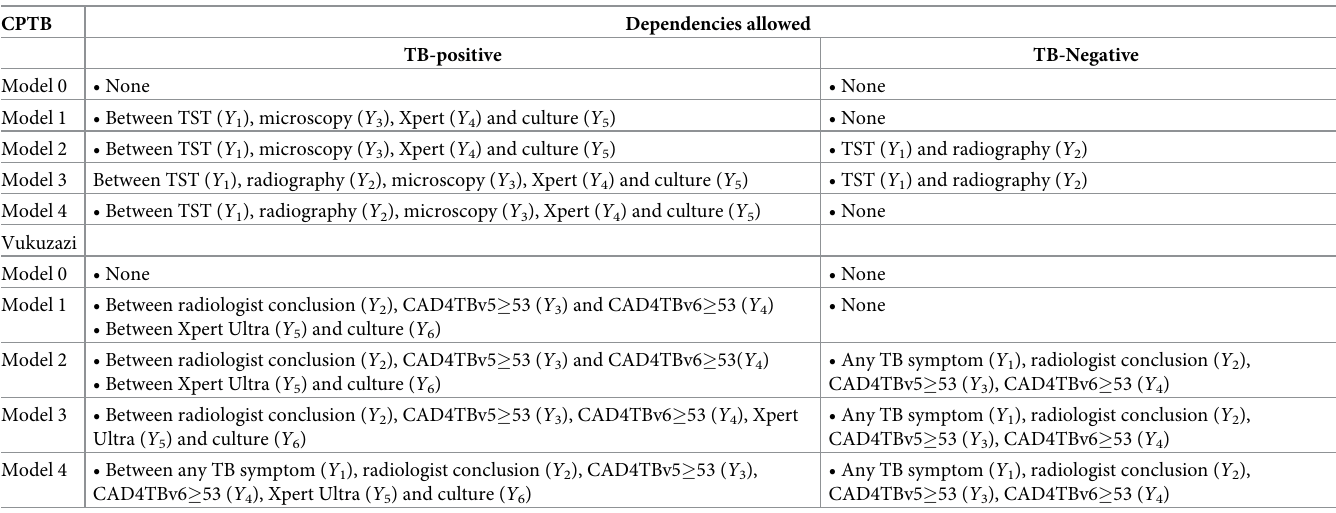
Table 1. Models considered in the analysis of CPTB and Vukuzazi datasets.